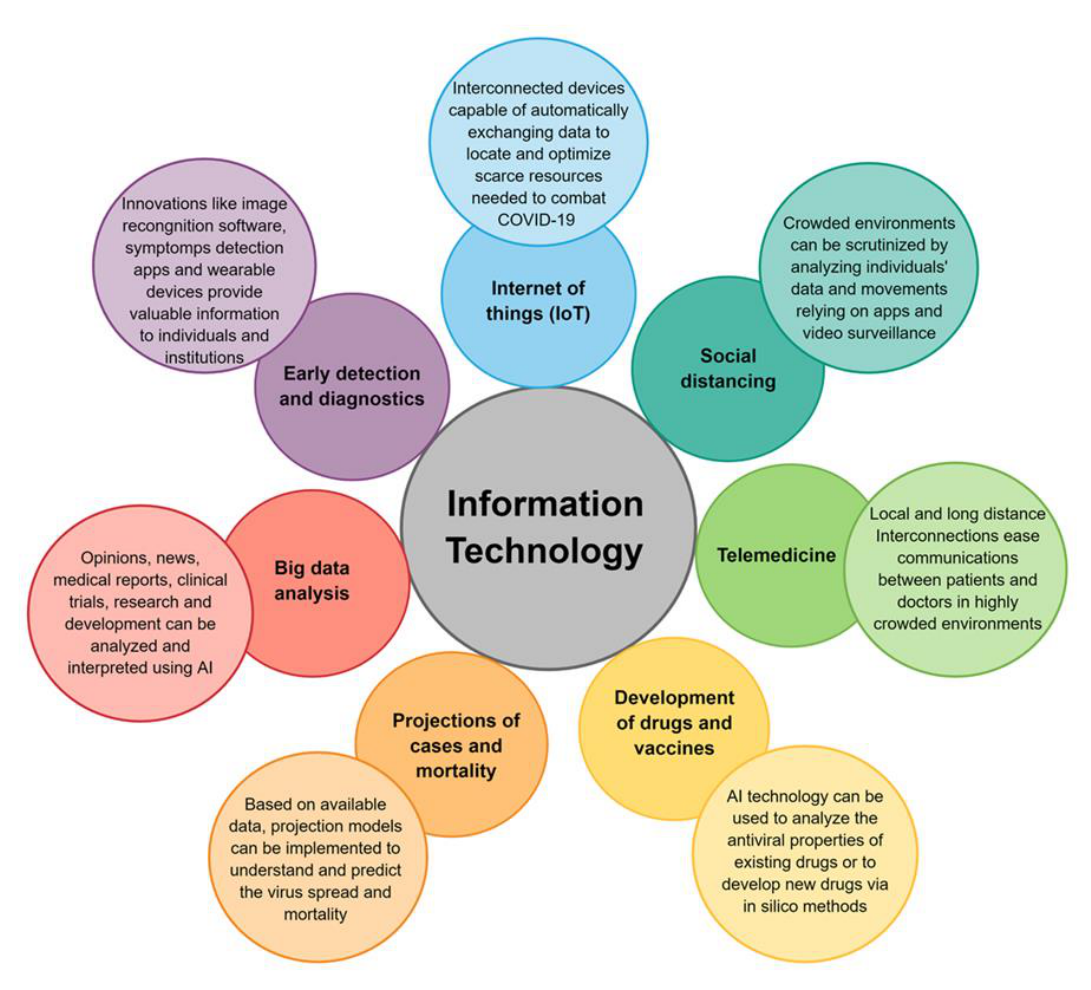
Figure 12. Main applications of information technology in combating COVID-19.